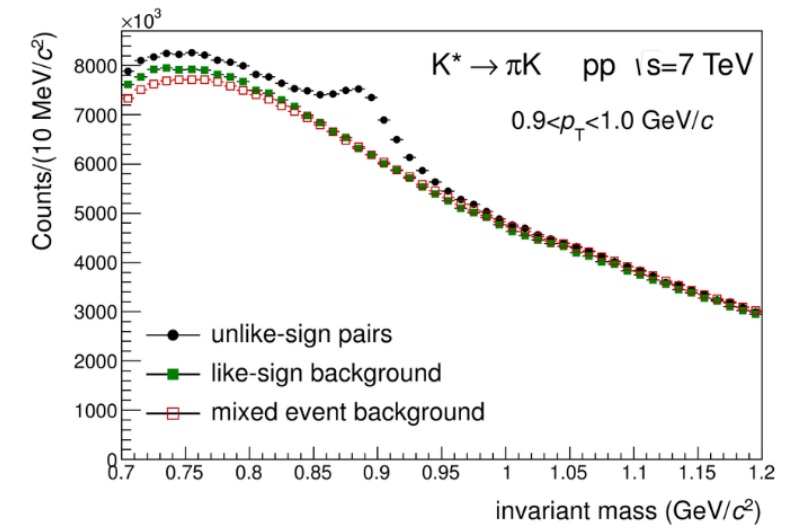
Figure 1. Comparison of π K M inv signal distribution, p T = 0.9–1.0 GeV/c, with different background estimations [1].